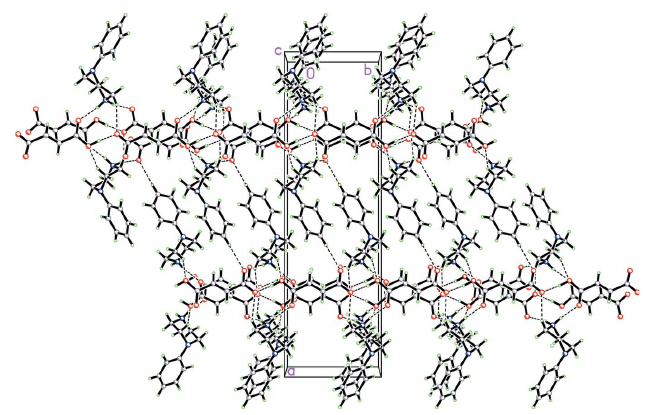
Figure 27 Packing diagram for 12 viewed along the c- axis direction showing the two C 1 (7) chains propagating in the b -axis direction involving the fumarate 1 anions and composed of O—H (cid:2)(cid:2)(cid:2) O hydrogen bonds which are in turn cross-linked by both N—H (cid:2)(cid:2)(cid:2) O hydrogen bonds and C—H (cid:2)(cid:2)(cid:2) O inter-